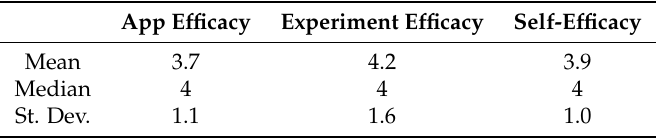
Table 6. Efficacy results (1 (poorly effective) to 7 (highly